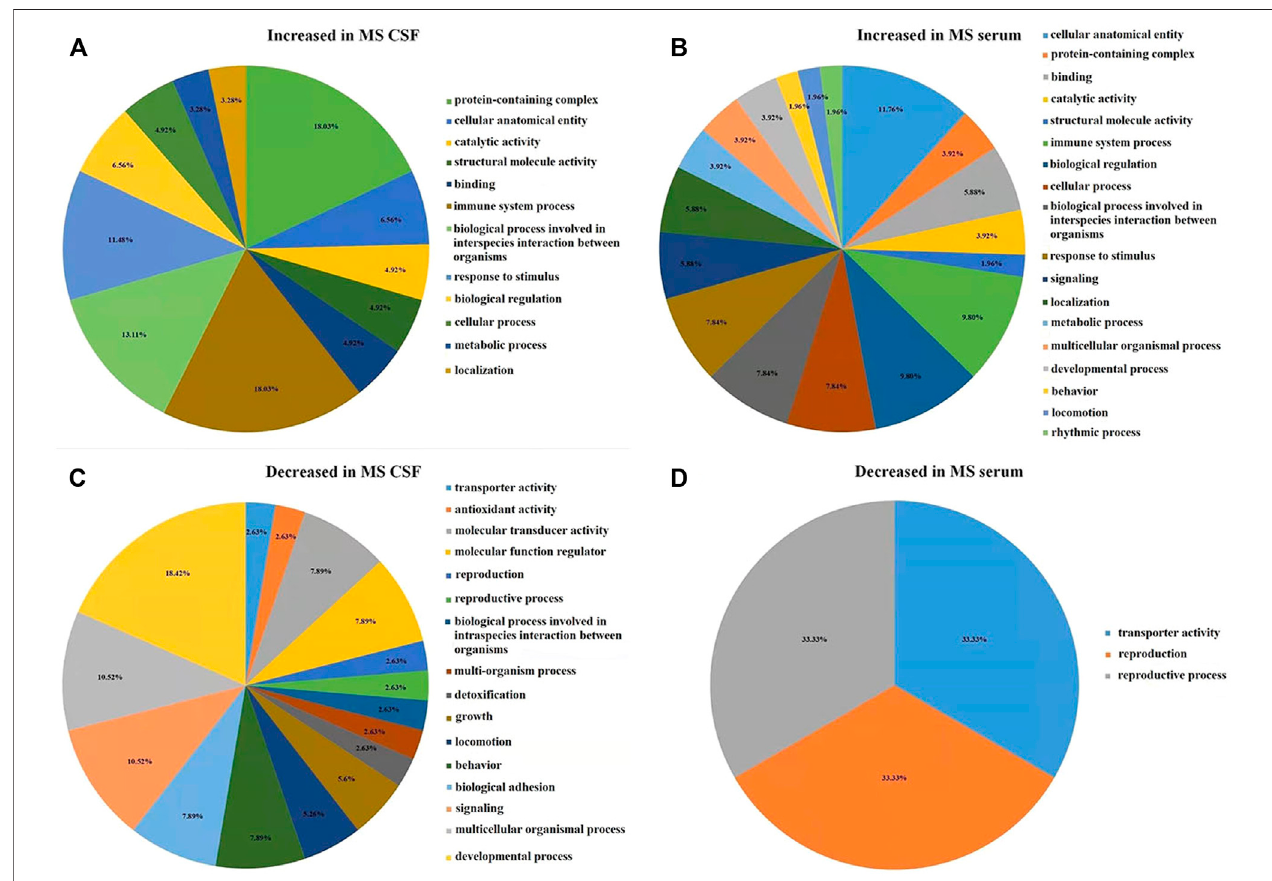
FIGURE 3 | The fi gure is calculated by the difference between the number of highly expressed and the number of low-expressed proteins in each GO item (Fold change=1.5). (A) InRRMSCSF, thenumber ofhighly expressedproteinswashigher thanthenumber oflow-expressedproteinsinGOentries. (B) InRRMSserum,the numberofhighlyexpressedproteinswashigherthanthenumberoflow-expressedproteinsinGOentries. (C) InRRMSCSF,thenumberoflow-expressedproteinswas higherthanthenumberofhighlyexpressedproteinsinGOentries. (D) InRRMSserum,thenumberoflow-expressedproteinswashigherthanthenumberofhighly expressed proteins in GO